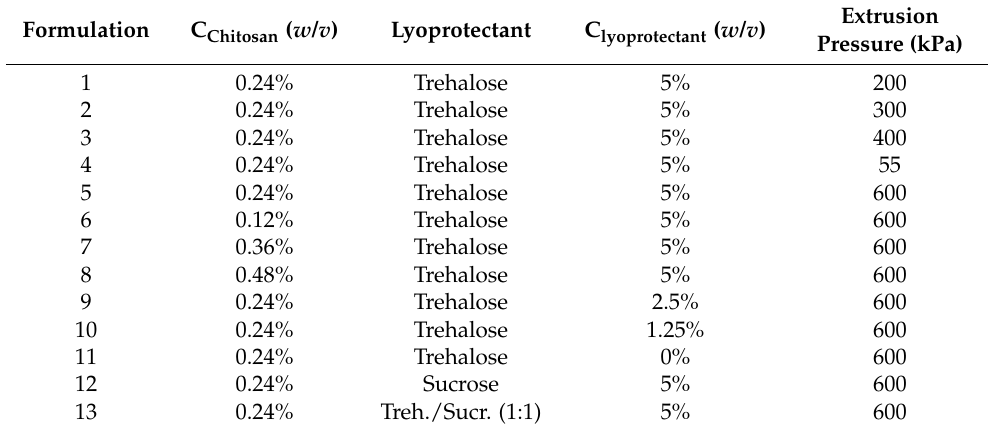
Table 1. Compositions of Ink